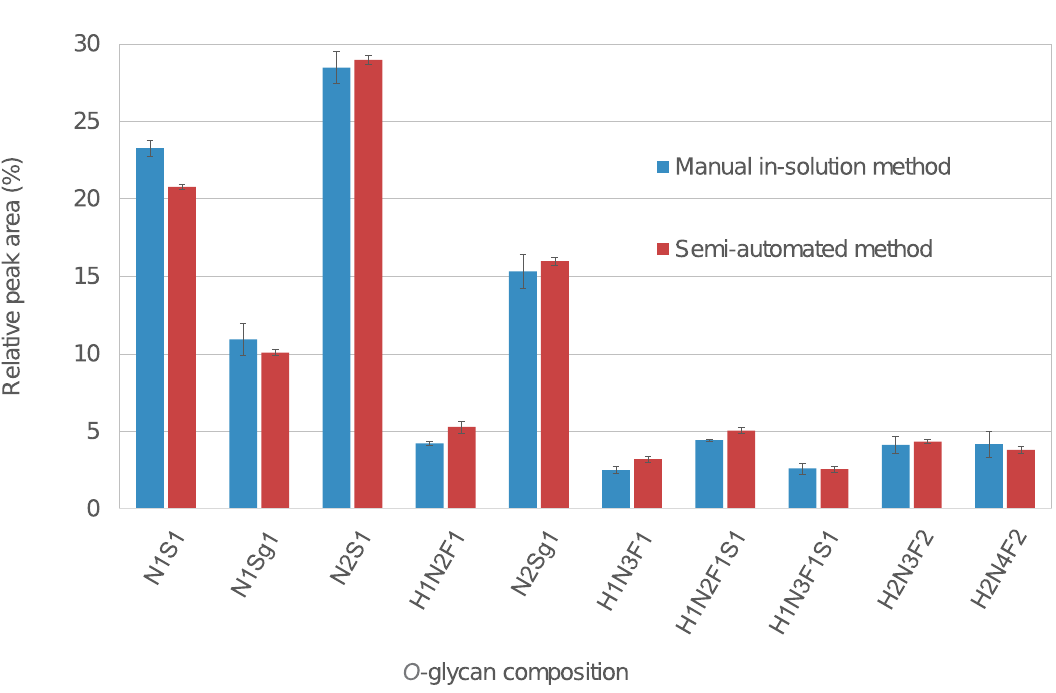
Fig 1. Comparison of the relative peak areas of ten representative O -glycans from 50 μ g of BSM type I-S analysed after sample preparation using the manual in-solution method and the liquid handling robot. Blue bars depict sample preparation using the manual in-solution method. Red bars depict sample preparation using the liquid handling robot. Error bars represent standard